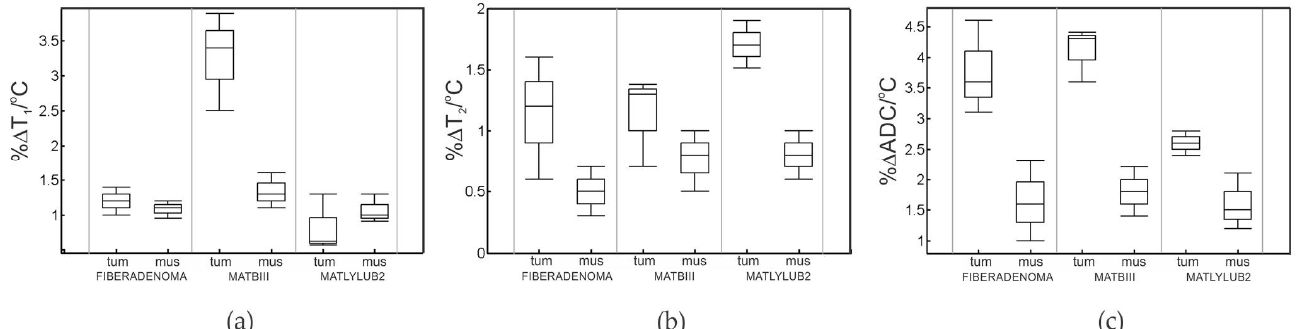
Figure 5. Box plots of MR thermal contrast change with temperature: ( a ) %ΔT 1 /°C, ( b ) %ΔT 2 /°C, and ( c ) %ΔADC/°C. Columns represent benign breast, malignant breast (MAT B III), and malignant prostate (MatLyLuB2), respectively (labeled “tum”), and muscle regions that were selected near those respective tumors (labelled “mus”). Each point plotted here represents 4 measurements for each tumor type or its surrounding muscle tissue.